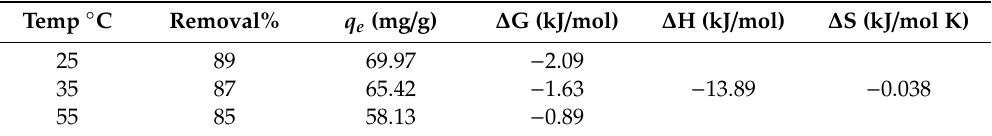
Table 3. E ff ect of temperature on removal e ffi ciency and thermodynamic parameters.